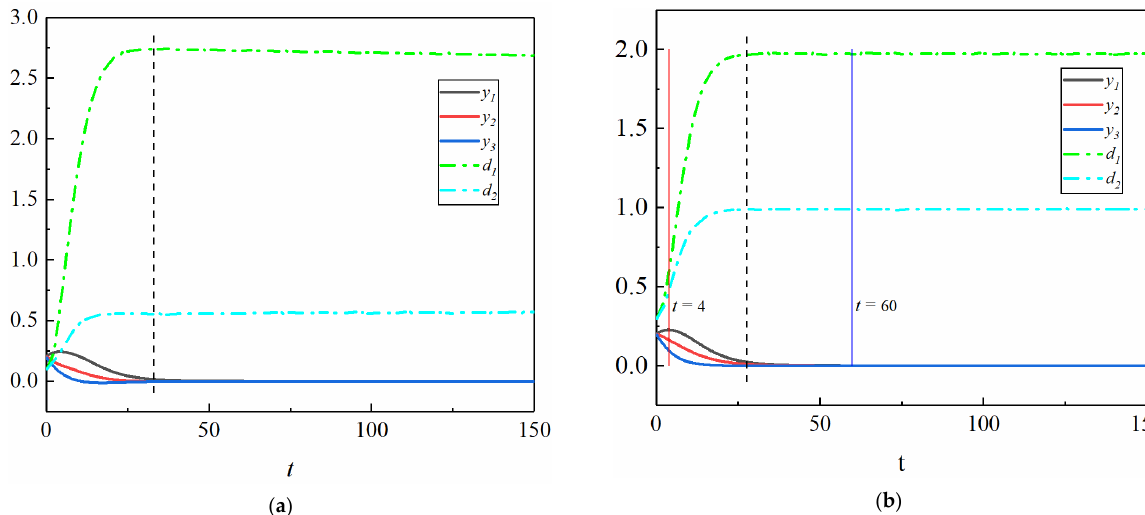
Figure 5. The trajectories of three particles and the variation of interparticle spacing with time. ( Wi = 0.5, α = 0.1, η r = 0.3, ε = 0.3, y 0 = 0.2). ( a ) d 1,0 = d 2,0 = 0.1; ( b ) d 1,0 = d 2,0 = 0.3. The thin red line represents t = 4: the stage of sharp change of particle spacing and cross-flow migration. The thin blue line represents t = 60: the stage of relatively stable particle spacing and particle migrate on the